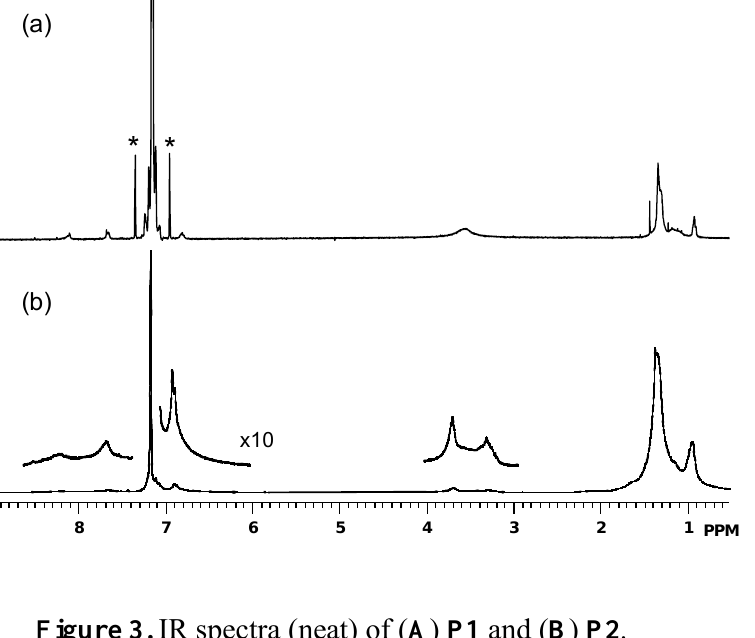
at 20 °C. The spinning side 3